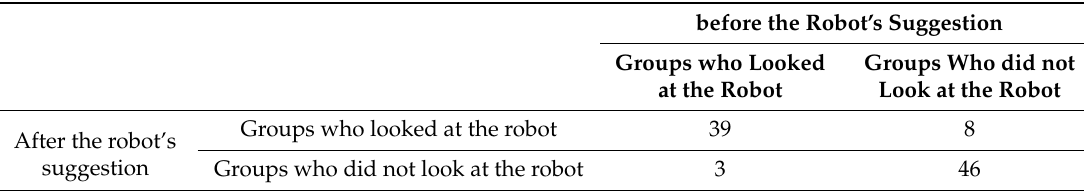
Table 8. Responses when the robot o ff ered a sample.